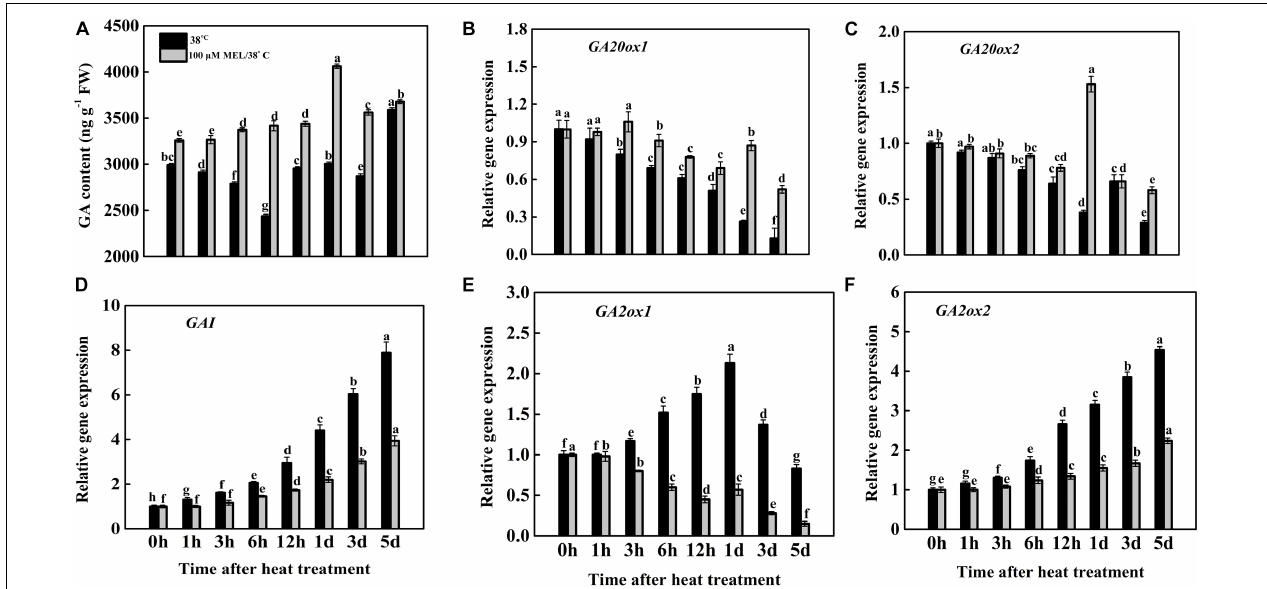
FIGURE 6 | Effects of exogenous melatonin treatment on the (A) endogenous GA content and (B,C) transcript abundance of GA biosynthesis genes ( GA20ox1 and GA20ox2 ), (D) GA signaling genes ( GAI ), (E,F) GA of catabolic genes ( GA2ox1 and GA2ox2 ) during heat stress with or without of melatonin treatment. Different letters denote the significant variations between the treatments and the average values were measured by Tukey’s Honestly Significant Difference (HSD) test at P < 0.05. Data represented as the mean ± standard error of triplicate biological replicates.